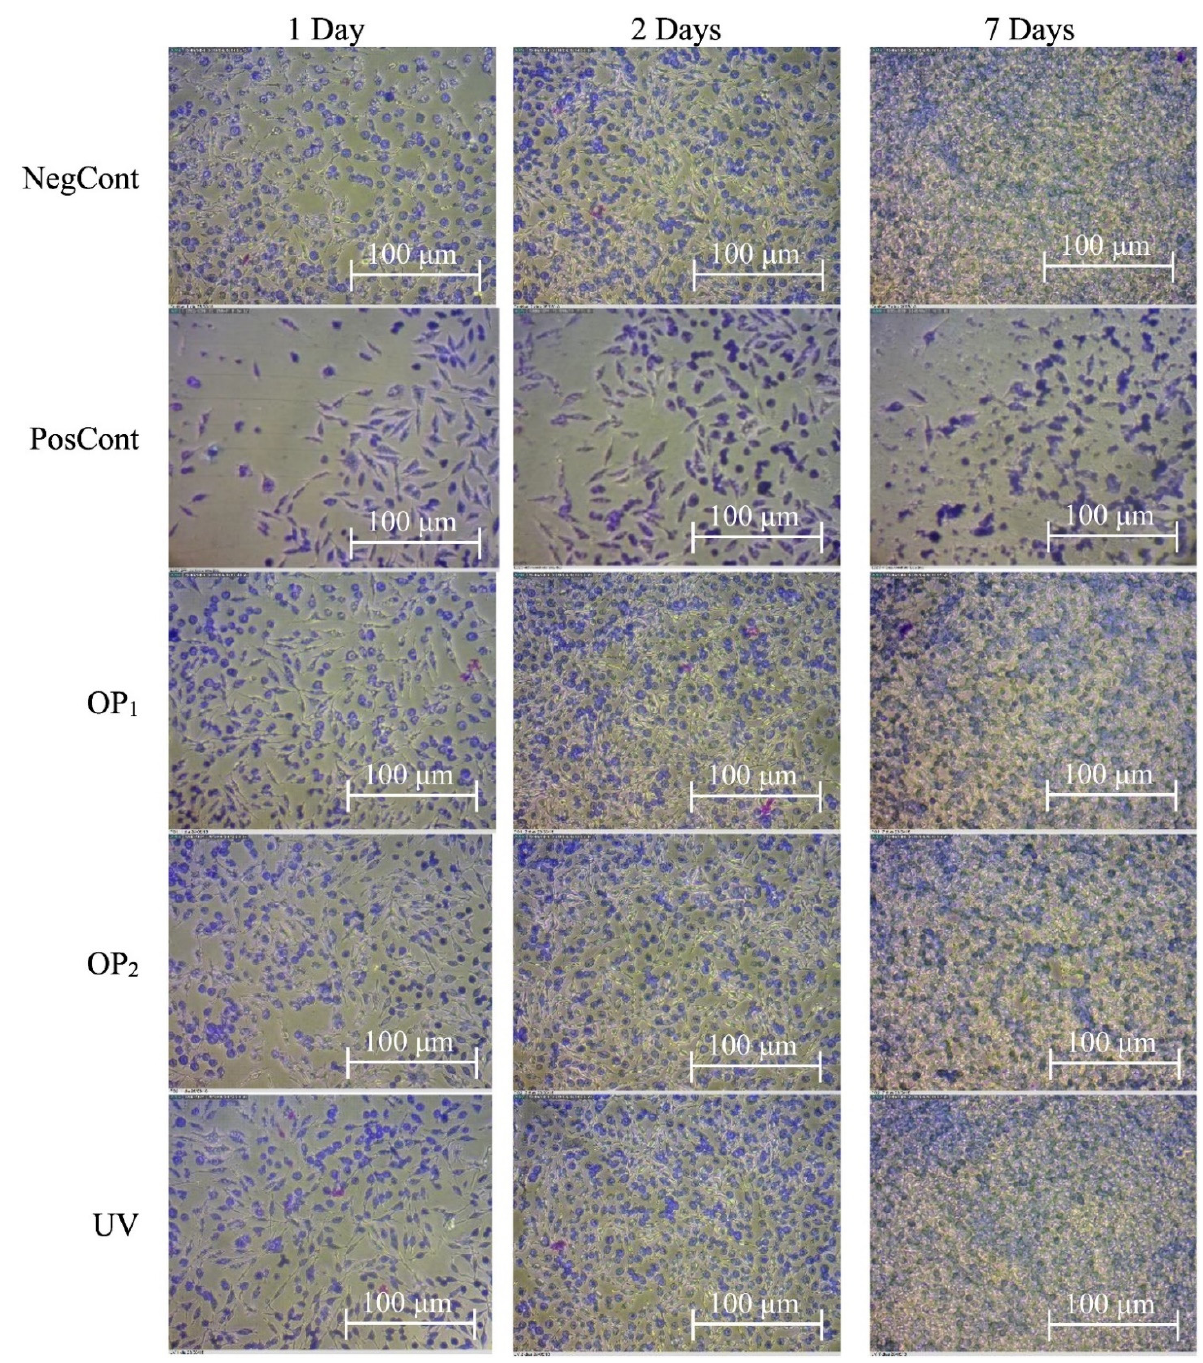
Figure 7. L929 cell attachment on untreated and treated UHMWPE. Reprinted with permission from [93].